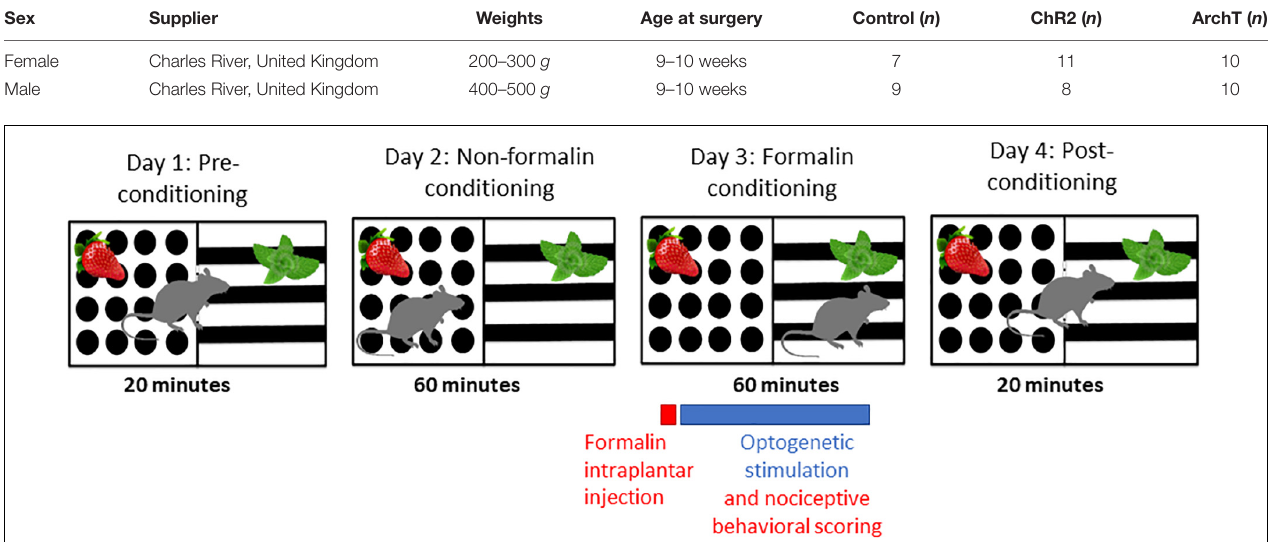
TABLE 1 | Summary of experimental groups.